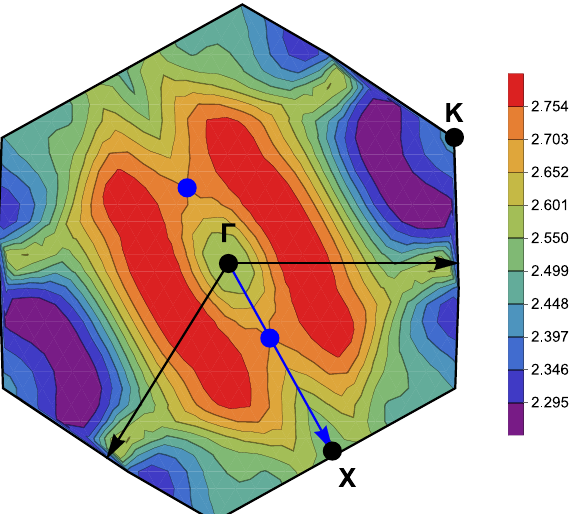
Fig. 4 2D electronic band structure and Van Hove singularities of the tail-to-tail domain wall. Energy of the top valence band for 39° (11 1 ) tail-to-tail domain wall (in eV) in the interface Brillouin zone. Black arrows represent the directions of the in-plane reciprocal lattice vectors. The blue arrow corresponds to the projection of the polarization change onto the domain wall plane. Van Hove singularities are indicated by blue